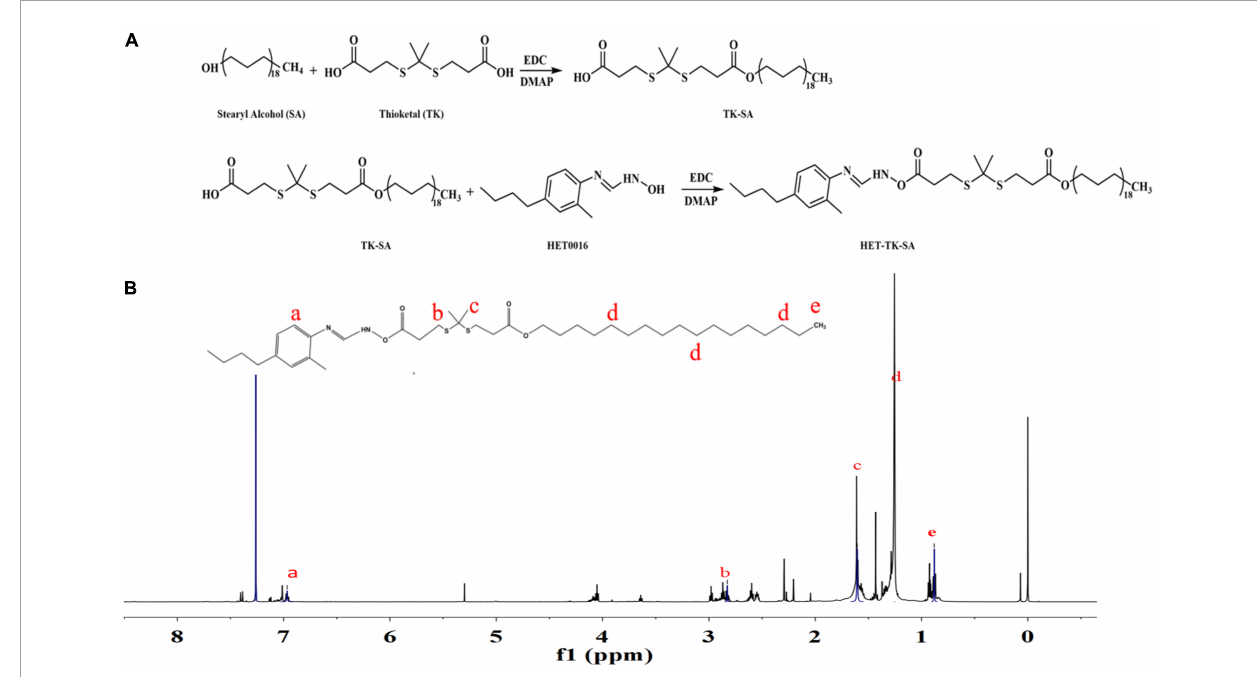
FIGURE2 Preparation and structure verification of prodrug. (A) The synthesis of HET-TK-SA. (B) The 1 H NMR spectra of HET-TK-SA in DMSO-D6: The characteristic peak of the carboxyl group in HET-TK-SA disappears at 12.01 ppm, the characteristic peak of HET0016 is when the chemical shift appears at 6.97–7.16 ppm, and the characteristic peak of stearyl alcohol appears at 0.88–1.25 ppm, indicating that the carboxyl group successfully reacts with HET0016, and HET-TK-SA is successfully